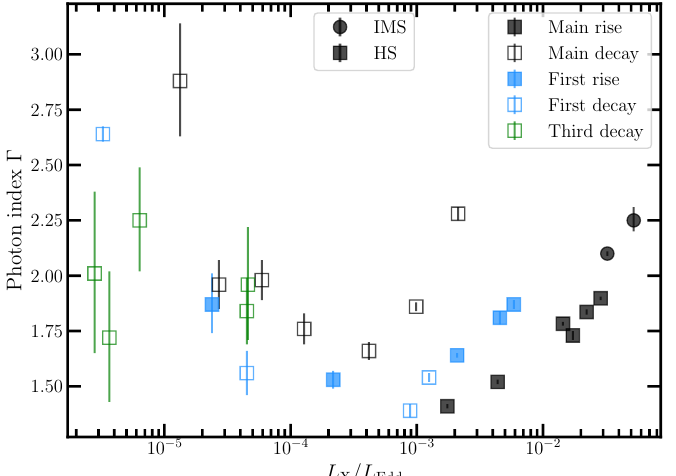
Figure 4. The photon index Γ versus the 1–10 keV X-ray luminosity (in Eddington units) of MAXI J1348-630. The circles represent the intermediate state (IMS) and the squares represent the hard state (HS). The filled and open symbols indicate separate outburst states, i.e., rise and decay, while different colors differentiate between different